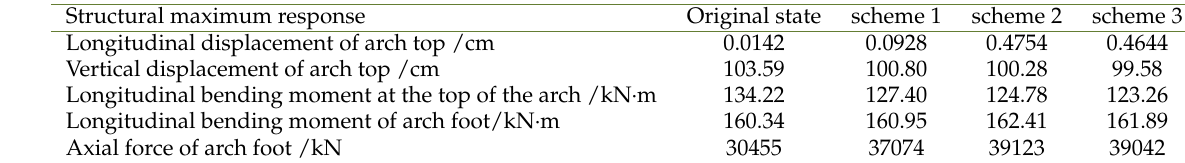
Table 6. Maximum response of structure under longitudinal seismic